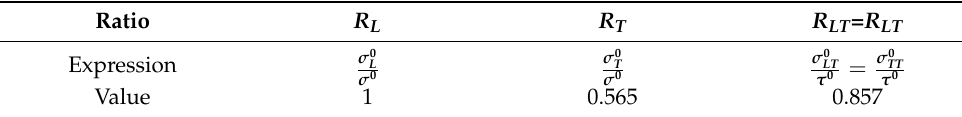
Table 4. Implementation of Hill’s potential function in ABAQUS using the yield stress ratios for the transverse isotropic material.